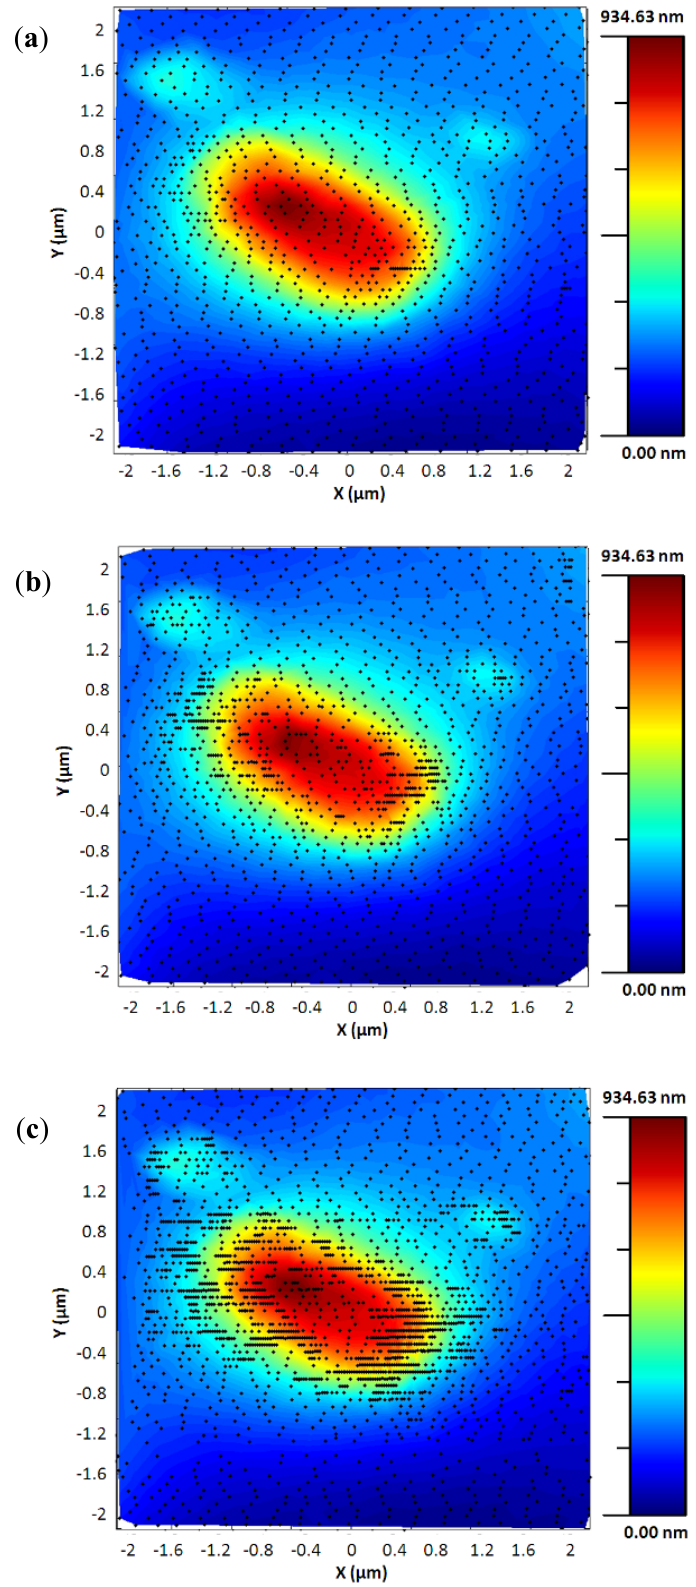
Figure 10. Tests of the adaptive controller over the same bacteria sample zone for different attenuation factors. ( a ) γ = 1, imaging time = 36 s. ( b ) γ = 2, imaging time = 43 s. ( c ) γ = 4, imaging time = 1 min 1 s. ( d ) γ = 6, imaging time = 1 min 13 s. ( e ) γ = 8, imaging time